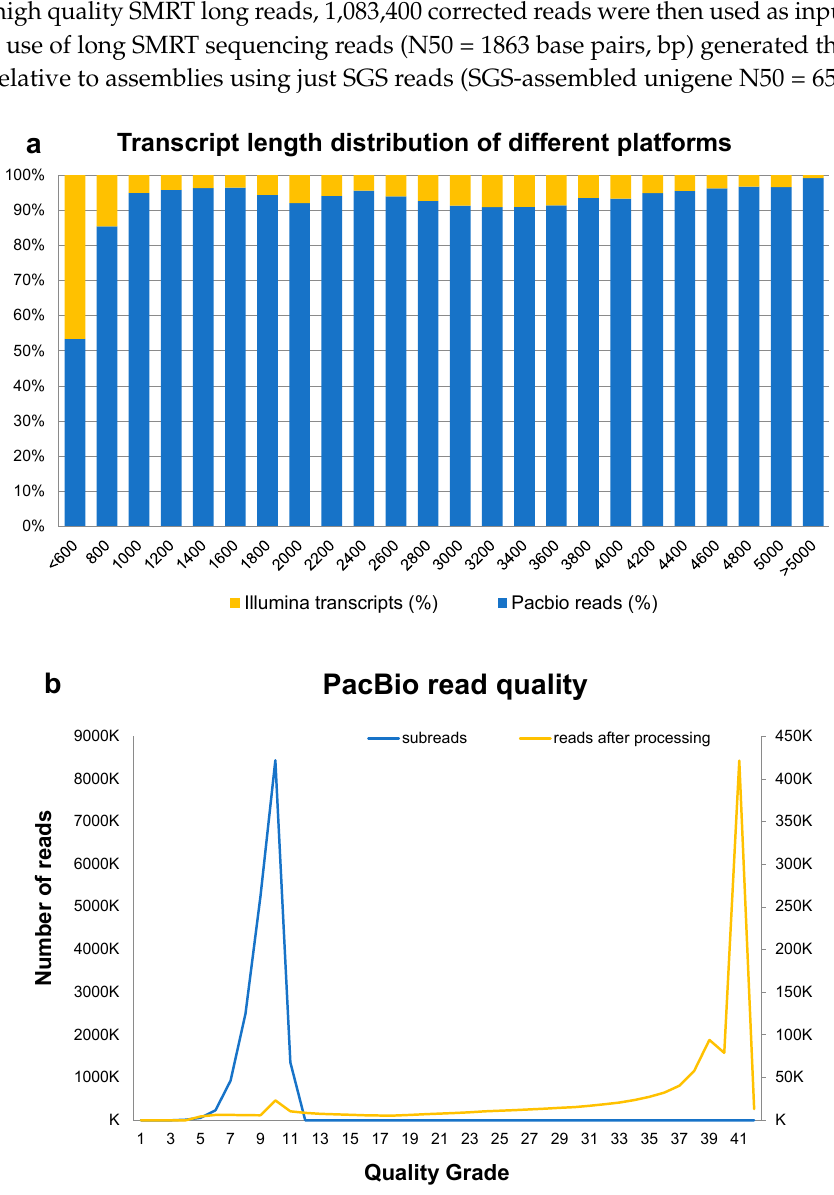
Figure 2. Distribution of D. officinale second-generation sequencing (SGS) and single-molecule real-time (SMRT) reads. ( a ) Transcript length distributions from the two different sequencing platforms; ( b ) PacBio quality of subreads and corrected reads.